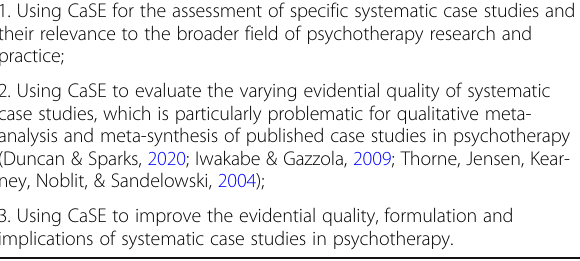
Table 2 How can Case Study Evaluation-tool (CaSE) be used in psychotherapy research and